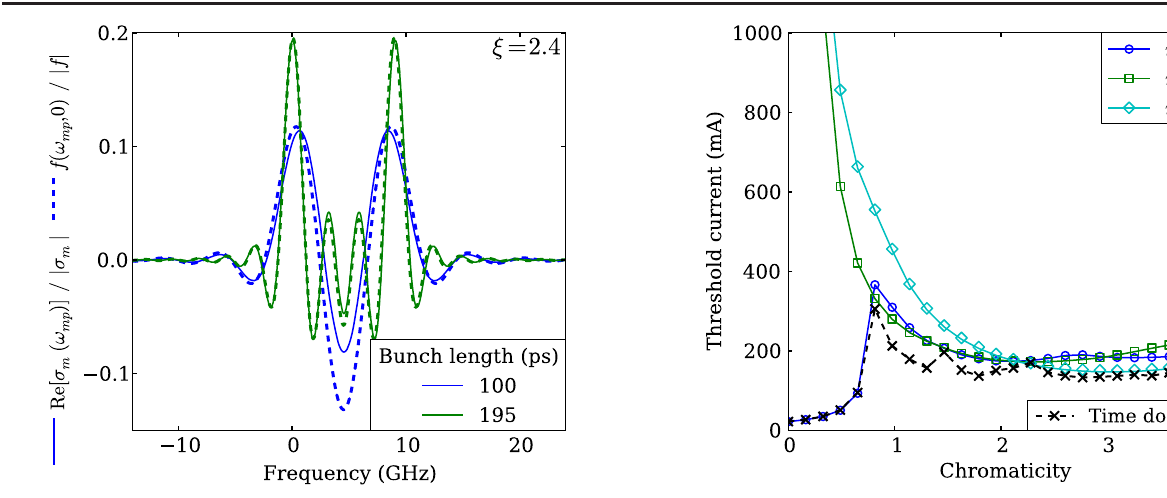
FIG. 18. Threshold current for the coupled-bunch resistive-wall FIG. 17. Comparison of the transverse bunch spectra σ for the m instability in the 3 GeV ring with a BBR included for the case flat potential condition, a chromaticity of 2.4 and two different with a short bunch in a single rf system. Results of macroparticle bunch lengths with the corresponding shaker modes excited at simulations in the time domain (dashed line) are compared ; 0 Þ . zero frequency f ð ω mp with those obtained using a frequency domain computation (solid